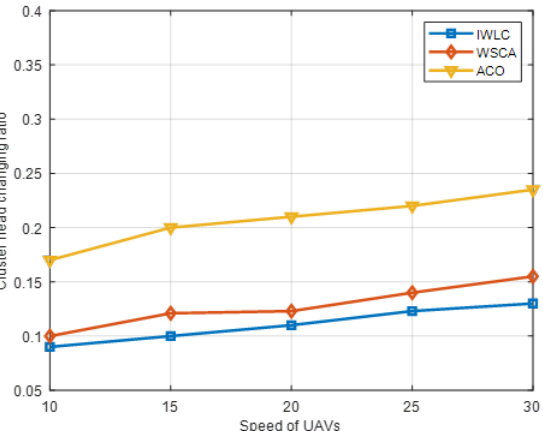
Figure 13. Cluster head changing ratio in different schemes with varying speeds of UAV nodes.